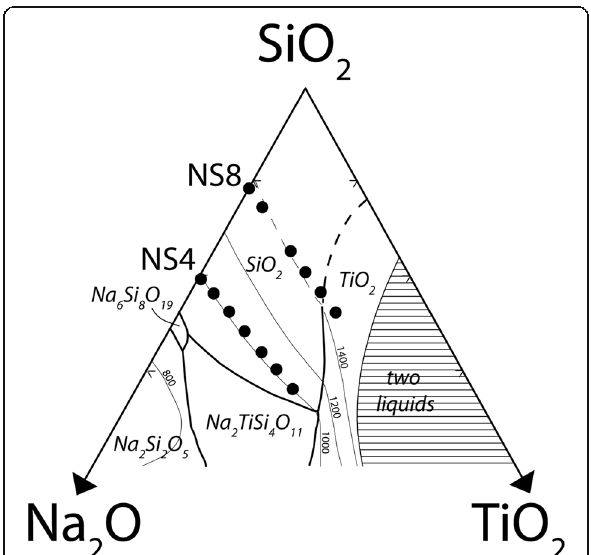
Fig. 1 Upper portion of the SiO 2 – Na 2 O – TiO 2 phase diagram. Our experiments were performed along the NS8 and NS4 joins. Experimental bulk compositions are denoted with black circles. Thin black lines are liquidus isotherms, and thick black lines are liquidus phase boundaries. (modified from Glasser and Maar